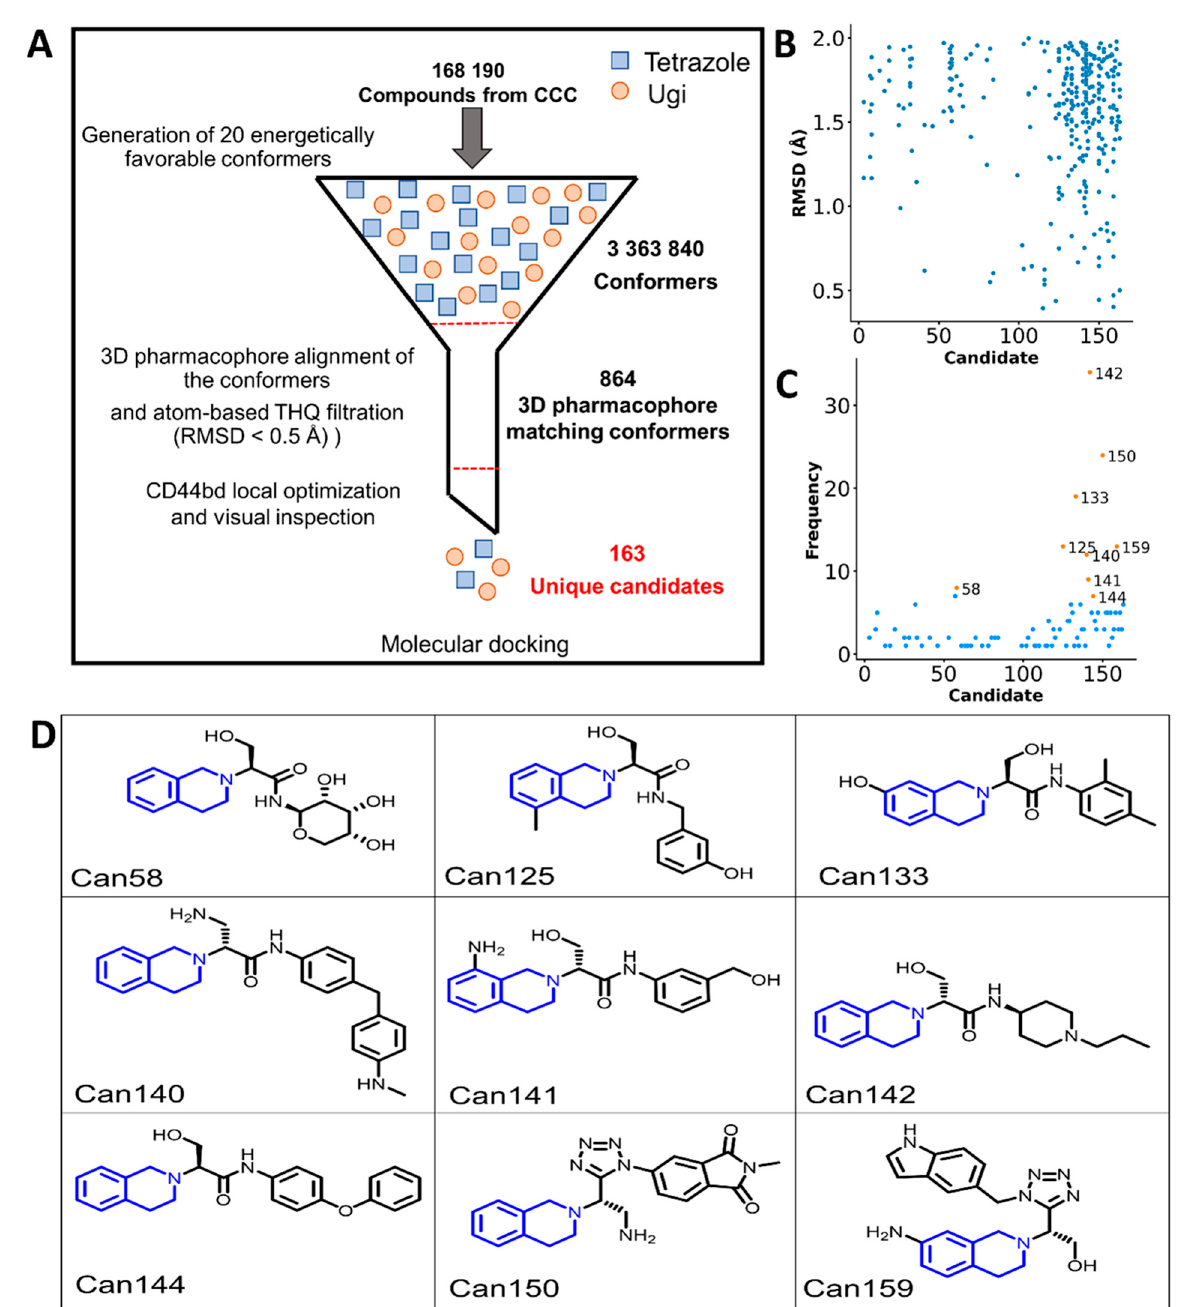
Figure 3. Virtual screening of THQ-containing molecules as potential CD44 antagonists. ( A ) The compounds within the CCC-generated libraries were sequentially filtered using the depicted strategy. ( B ) RMSD analysis comparing the THQ position in crystals vs. the poses obtained by docking of 163 unique compounds to human or mouse CD44HAbd. ( C ) Analysis of the frequency of poses with RMSD < 2 Å allowed the selection of nine candidates (orange dots). ( D ) Structure of the nine candidates selected by virtual screening with the THQ motif highlighted in blue.